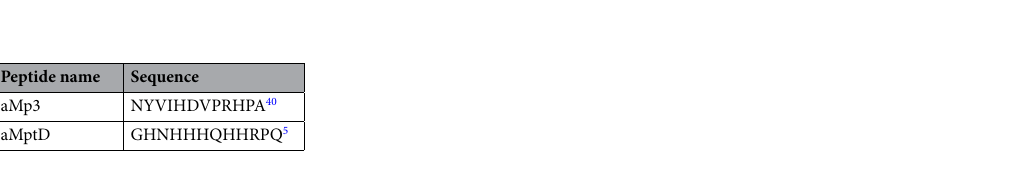
Table 4. Capture peptides used for coating Dynabeads MyOne Tosylactivated and their